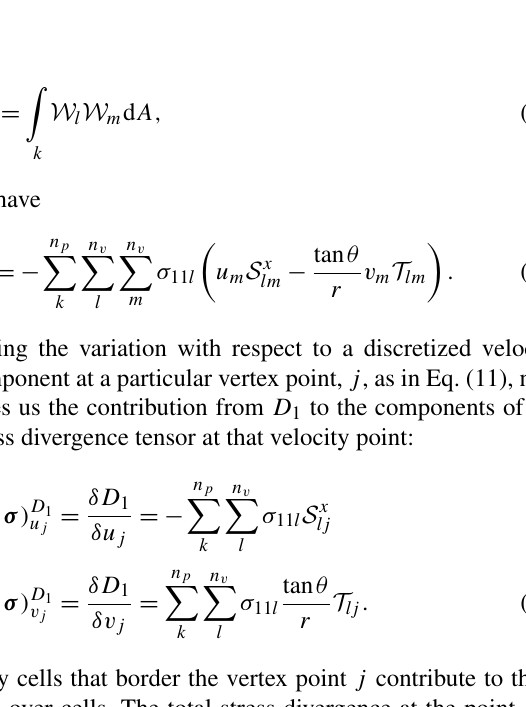
Figure 2. Example basis functions for the (a–d) Wachspress and (e–h) PWL methods. The basis function is shown for the top vertex for a (a, e) square, (b, f) pentagonal, (c, g) hexagonal, and (d, h) heptagonal cell. Contour levels are drawn between 0.1 (dark blue) and 0.9 (red) at intervals of